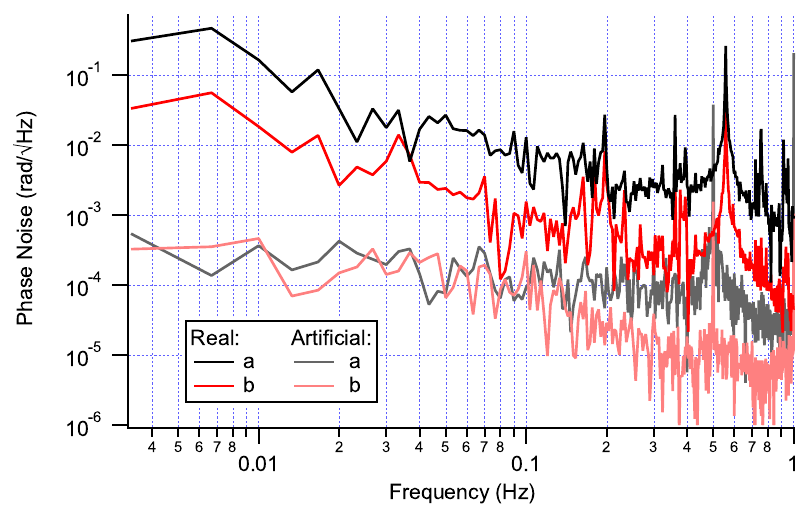
Figure 5. Measured phase noise of each species. Traces labeled “Real” are recorded when the Xe isotopes are excited on resonance. Traces labeled “Artificial” are recorded when the Xe isotopes are both driven off resonance (not excited) and an AC B y is applied to the magnetometer at the off-resonance drive